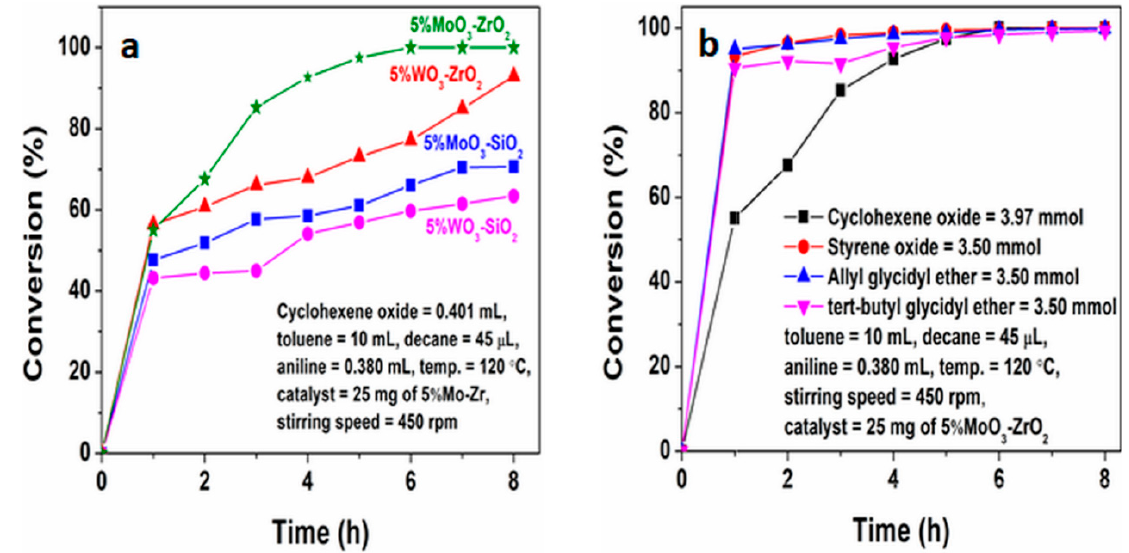
Figure 3. ( a ) The activity of various catalysts on the ring-opening of cyclohexene oxide and ( b ) the ring-opening of several epoxides.